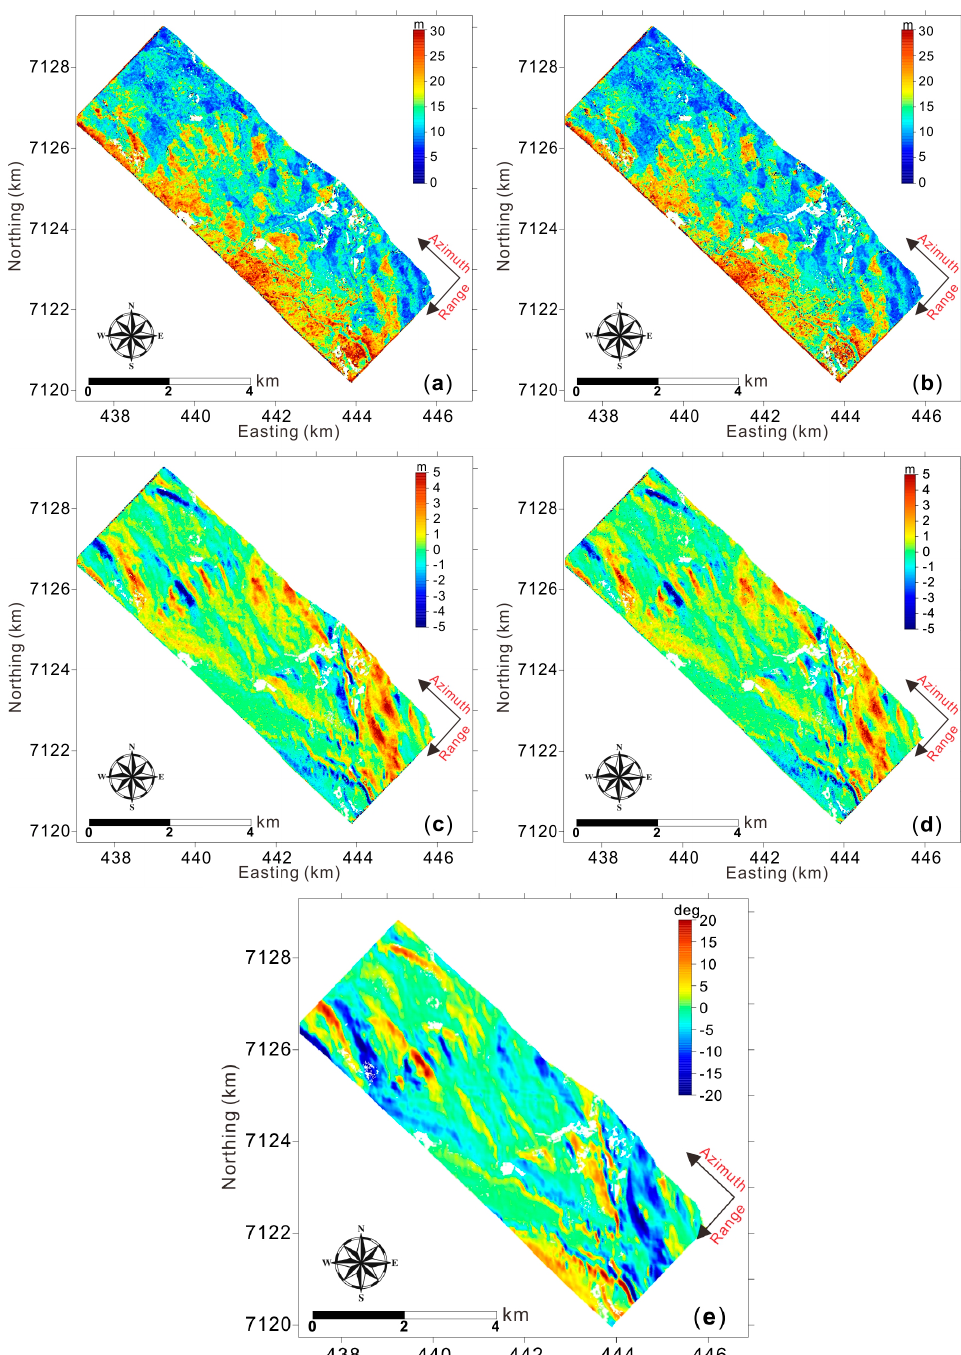
Figure 5. Forest height inversion results from the modified DBPI method. ( a ) Image 1-2 as the first baseline with modified DBPI; ( b ) Image 1-3 as the first baseline with modified DBPI. ( c ) Difference values of forest height between the modified DBPI and DBPI results with image 1-2 as the first baseline, scaled from − 5 m to 5 m; ( d ) Difference values of forest height between the modified DBPI and DBPI results with image 1-3 as the first baseline, scaled from − 5 m to 5 m; ( e ) The range terrain slope map, scaled from − 20° to 20°.